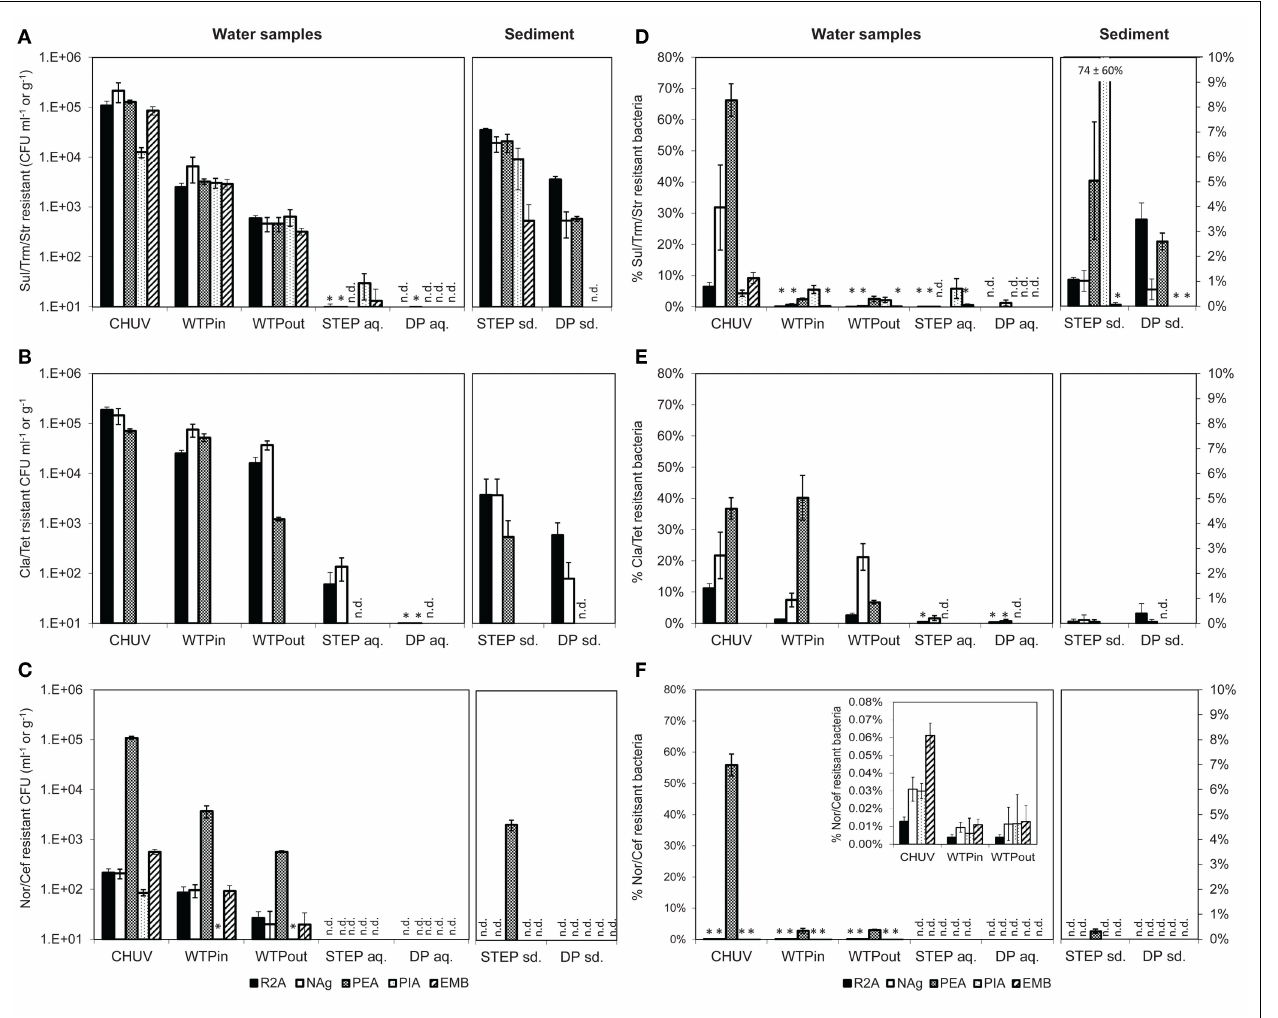
FIGURE 4 | (A–C) Total viable counts, normalized to sample volume or mass, in the presence of (A) Sul/Trm/Str, (B) Cla/Tet, and (C) Nor/Cef. (D–F) Abundance, relative to total viable counts without antibiotics, in the presence of (D) Sul/Trm/Str, (E) Cla/Tet, and (F) Nor/Cef.The insert in (F) shows